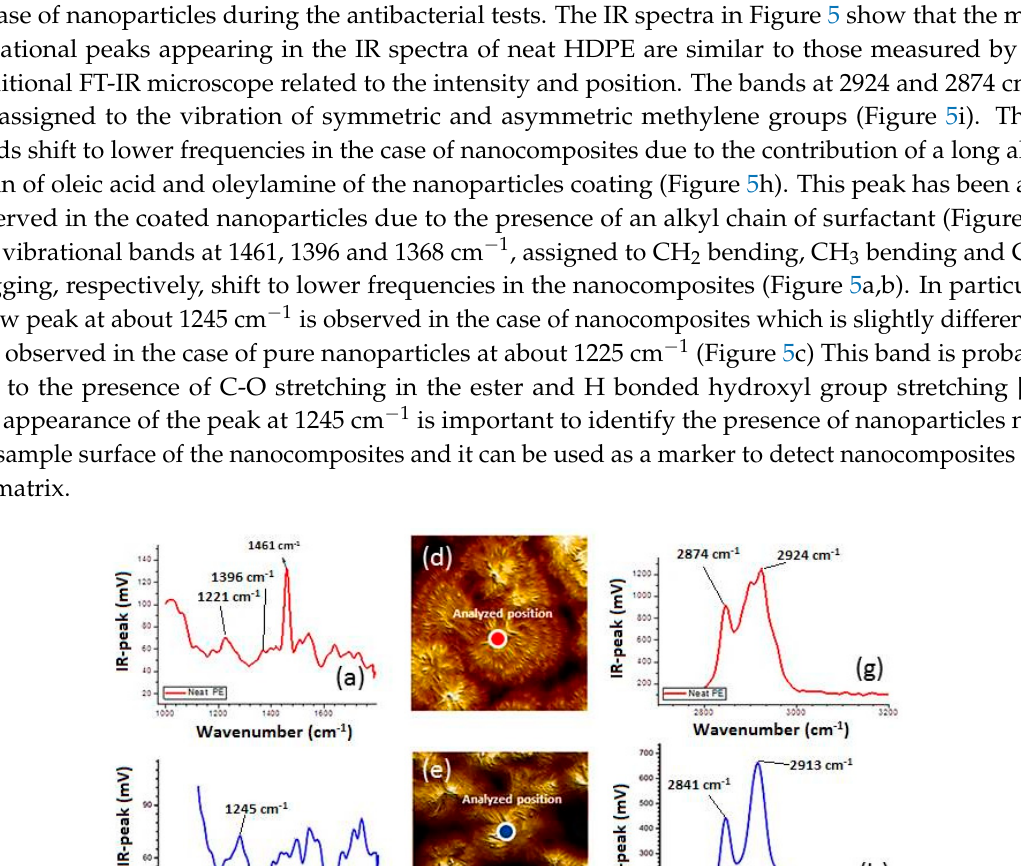
Figure 1 . TEM images of oleic acid (OA)/ oleylamine (OLA) coated Fe 3 O 4 NPs: ( a ) and FeAg NPs ( b , c ) dispersed in DBC and ( d ) the nanoparticle size distribution of Fe 3 O 4 nanoparticles and Ag NPs. The insert image in Figure 1c shows an illustration of hybrid nanoparticles.